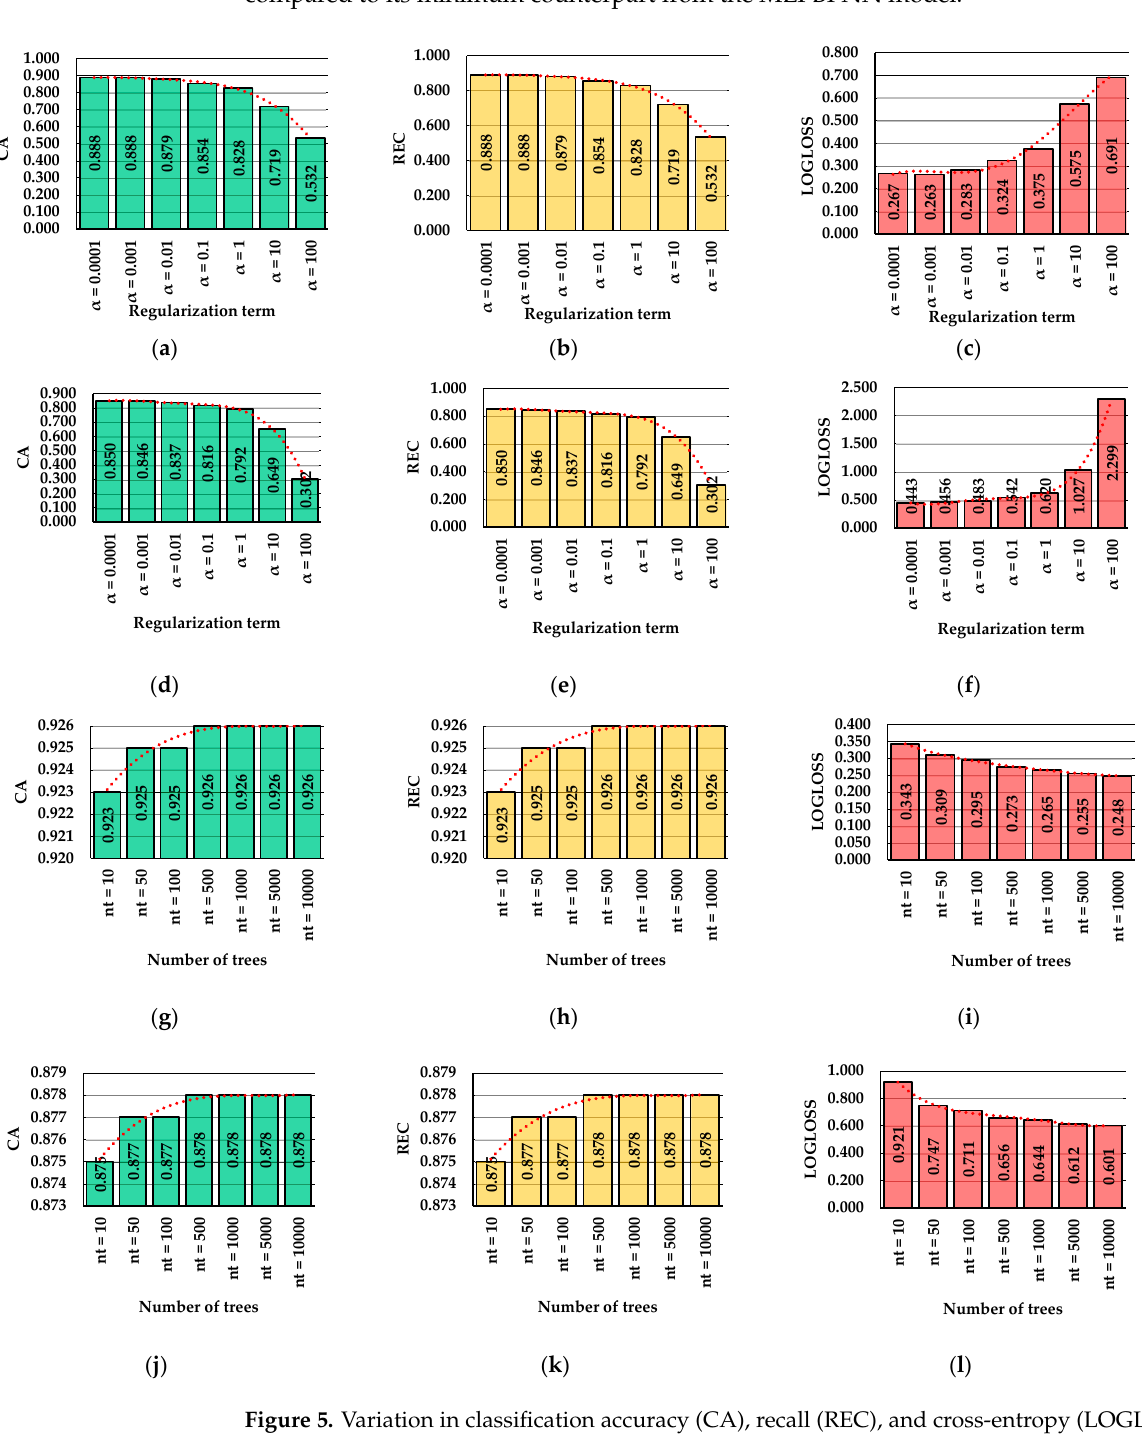
Figure 5. Variation in classification accuracy (CA), recall (REC), and cross-entropy (LOGLOSS) by parameter tuning: ( a – c ) results of the two-class problem of evaluating the classification performance over dynamic and static work by the MLPBNN as a function of the regularization term; ( d – f ) results of the 13-class problem of evaluating the classification performance over back postures by the MLPBNN as a function of the regularization term; ( g – i ) results of the two-class problem of evaluating the classification performance over dynamic and static work by the RF as a function of the number of trees; ( j – l ) results of the 13-class problem of evaluating the classification performance over back postures by the RF as a function of the number of trees. The maximum classification accuracy (CA) for the two-class (dynamic vs. static